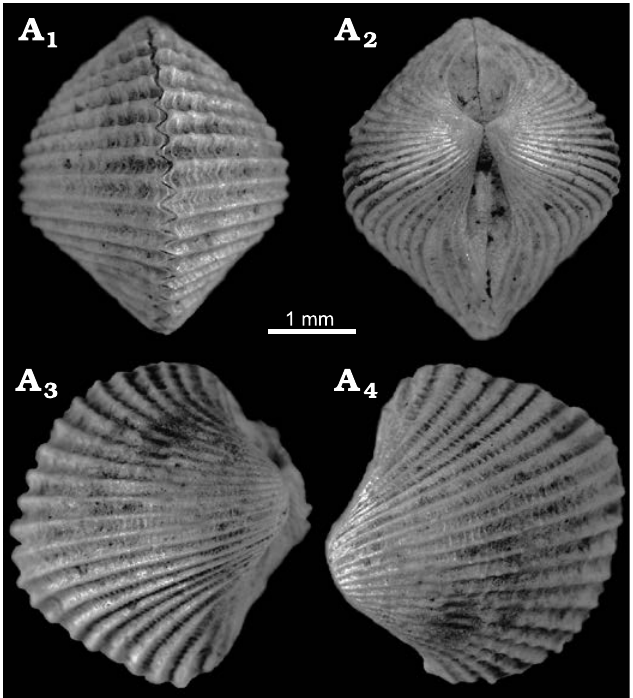
Fig. 28. Cardiid bivalve Septocardia pichleri (Bittner, 1895) from Lago Antorno, northern Italy, Cassian Formation, Carnian, Upper Triassic. PZO 12866, in ventral (A 1 ), dorsal (A 2 ), and lateral (A 3 , A 4 )